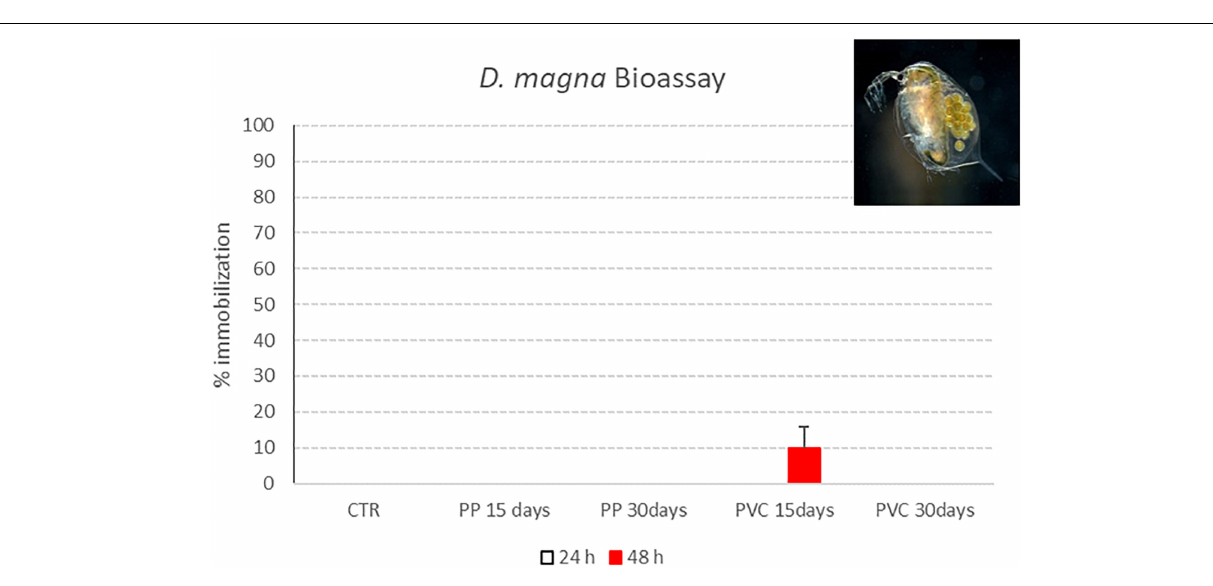
FIGURE 8 | Immobility percentage of D. magna neonates exposed to PP 15 days, PP 30 days, PVC 15 days and PVC 30 days (samples after degradation with photocatalytic device). Red bars indicate immobilization percentages recorded 48 h of exposure (M ± ES; n =